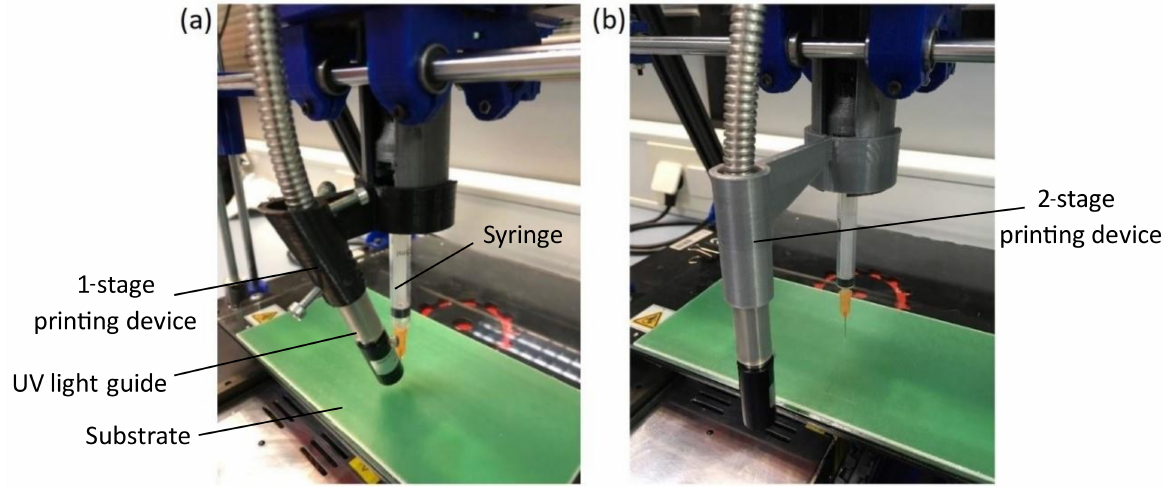
Figure 1. Alternative designs for housing the UV curing lamp to the 3D printer: ( a ) 1-stage printing device and ( b ) 2-stage printing